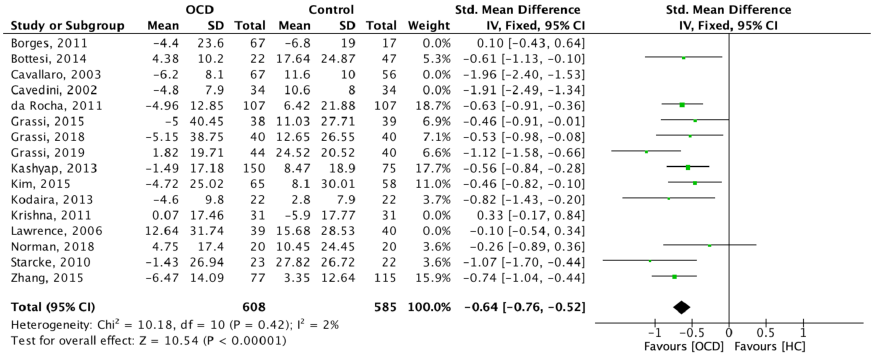
Figure 4. Forest plot of the main meta-analysis after removing potential outliers.